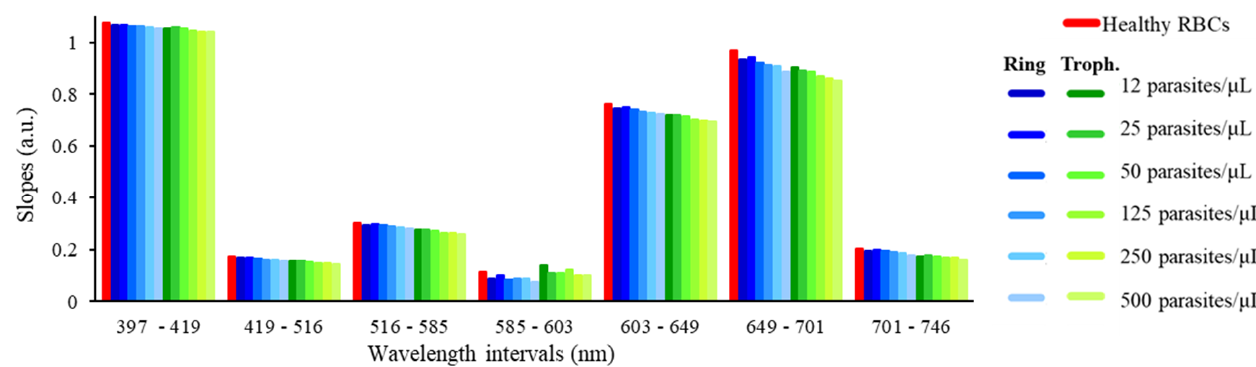
Figure 11. Bar plots representing the slopes of the lines between the experimental reconstructed reflectance spectra (%) at different wavelengths (397–419 nm, 419–516 nm, 516–585 nm, 585–603 nm, 603–649 nm, 649–701 nm, 701–746 nm), for uninfected (red) and P. falciparum -infected RBCs samples (with different parasitaemia values, between 12 and 500 parasites/ µ L of RBCs), in both early (blue, rings) and late (green, trophozoites) developmental stages. Table 2. Variation in the slopes (%) obtained for each P. falciparum -infected RBCs sample (with different parasitaemia values, between 12 and 500 parasites/ µ L of RBCs), when compared to the uninfected RBCs, for the different wavelength intervals: 397–419 nm, 419–516 nm, 516–585 nm, 585–603 nm, 603–649 nm, 649–701 nm, 701–746 nm. Slope Variation (%) Rings (Parasites/ µ L) Trophozoites (Parasites/ µ L) Wavelength Interval